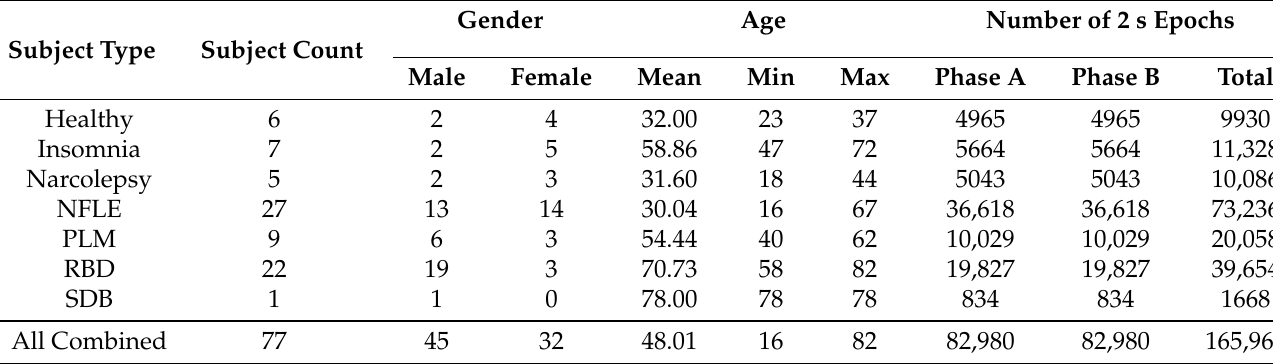
Table 1. Demographic details of the subjects used in this study.